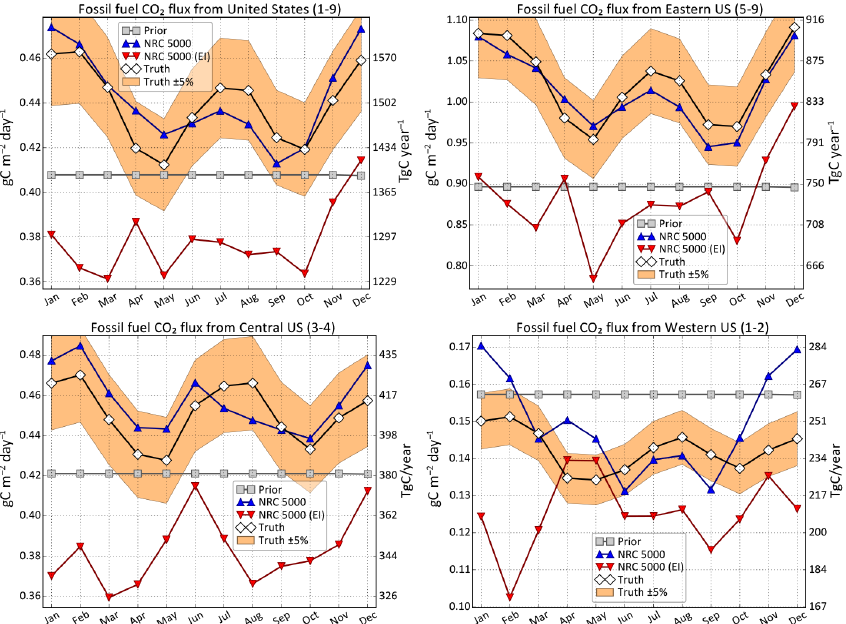
Figure 11. Monthly total fossil fuel CO 2 emission estimates along with prior and true fluxes aggregated for the conterminous US and neighboring groups of regions identified in Figure 5, using perfect (NRC 5000) and intentionally biased transport (NRC 5000 (EI)). As discussed in the text, estimates for biased transport are in this case uniformly low because of systematic differences in the vertical transport between the two model